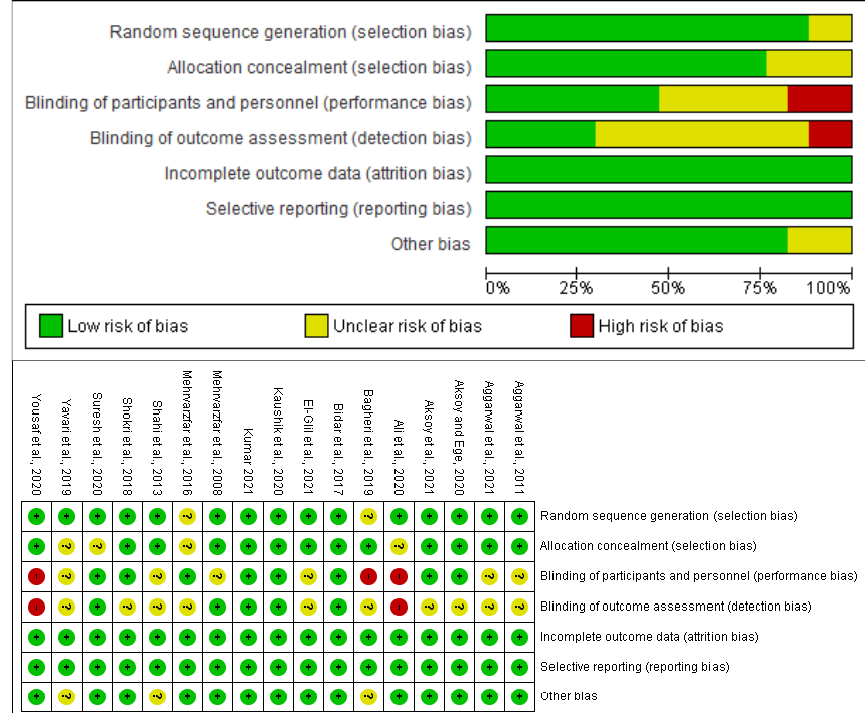
Figure 1. Study flowchart.